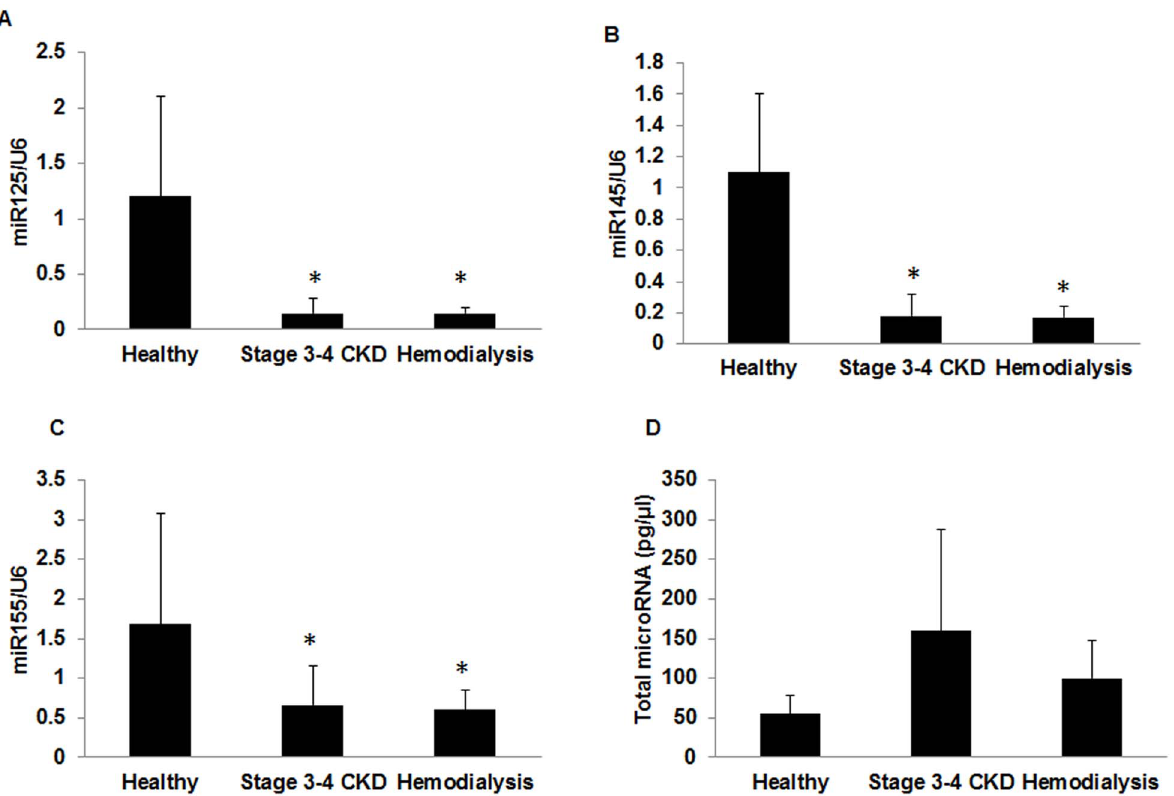
Figure 1. Circulating miRNA levels in controls, CKD patients and hemodialysis patients in freshly isolated samples. Sera were collected from stage 3–4 CKD patients (n=10), hemodialysis patients (n=10) and healthy volunteers (n=8) and total RNA isolated and real time PCR performed to determine the expression of circulating levels of miR-125b (A), miR-145 (B) and miR-155 (C) normalized by U6. Total serum miRNA concentration in the three groups was measured using Agilent Bioanalyzer (D) to demonstrate that the proportion of miRNA to total RNA analyzed is not the etiology of decreased expression of these specific miRNA. Each sample was assayed in triplicate. Data were expressed as mean 6 SEM. * p , 0.01 compared to healthy volunteers; ** p , 0.05 compared to healthy volunteers.